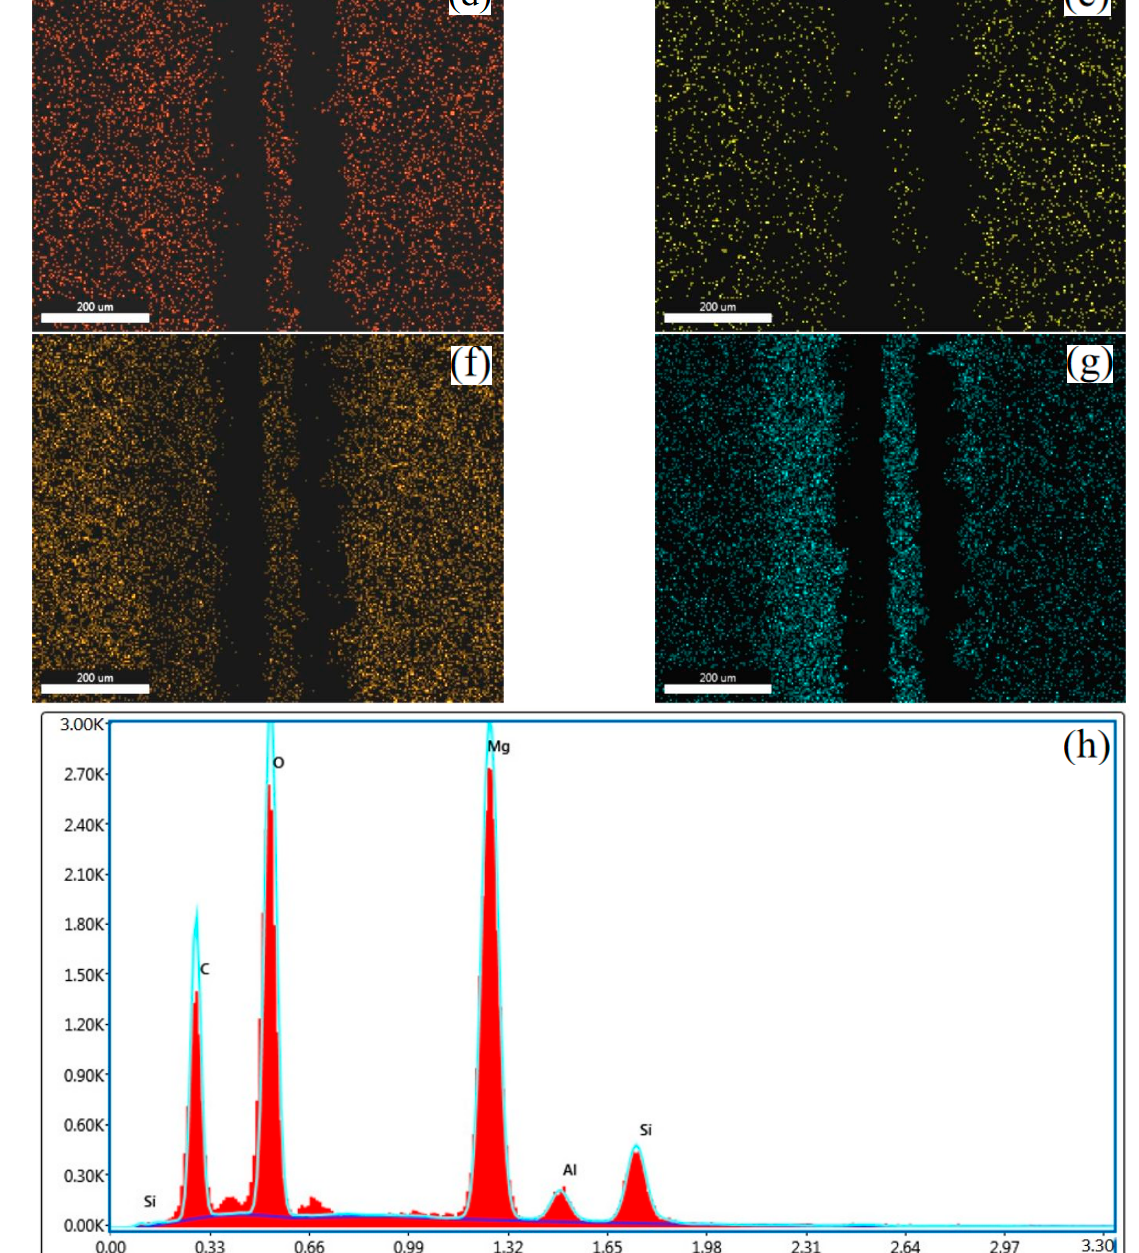
Figure 8. Laser etching of SiC/Mg composite microstructure and interfacial element distribution: ( a ) laser power 30 W, ( b ) general map of regional element distribution, ( c ) Al element distribution, ( d ) C element distribution, ( e ) Si element distribution, ( f ) Mg element distribution, ( g ) O element distribution; ( h ) peak content of each element.